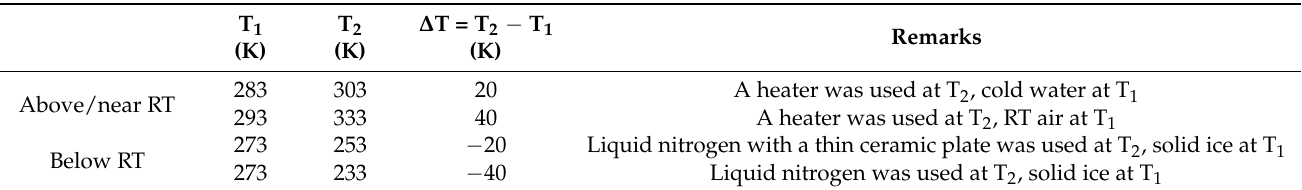
Table 2. The selected temperatures and temperature gradients are used to measure the power- generation characteristics of a single-leg module of TOS film above/near and below